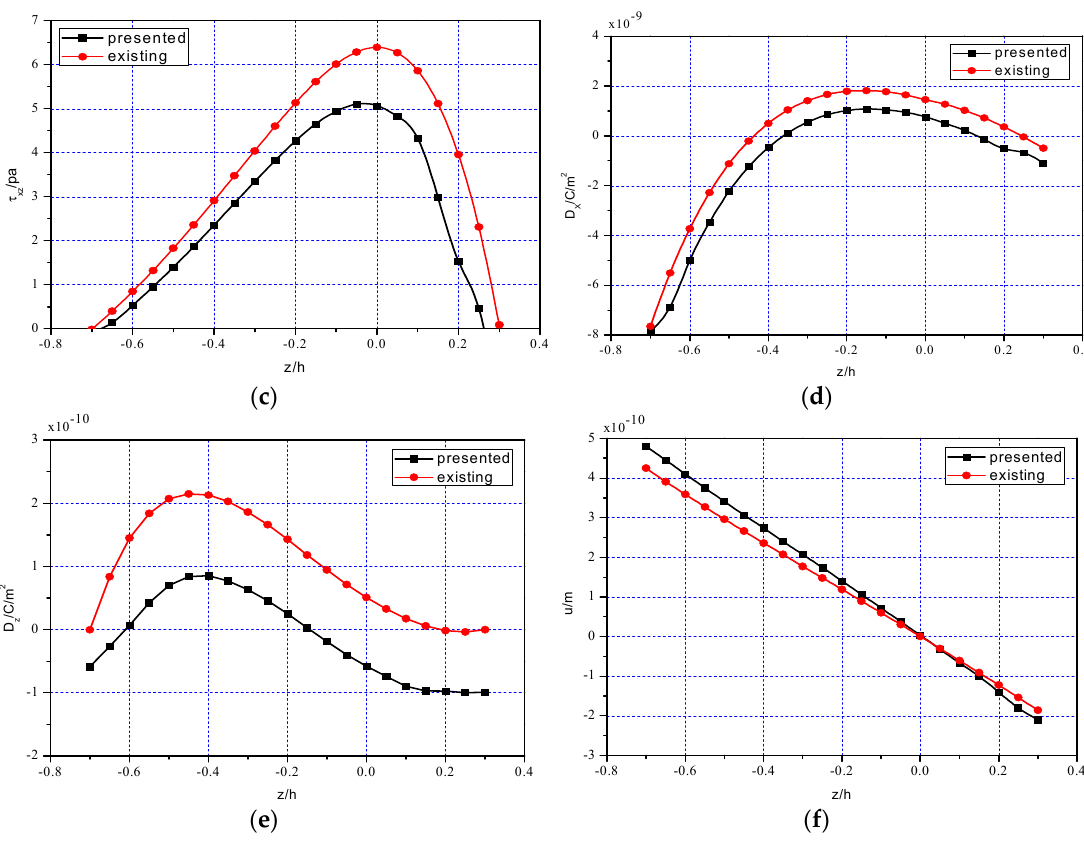
Figure 10. Comparisons of two-dimensional simulation presented in this study and existing solution from He et al. [27] at x = 0.75 l : ( a ) Stress σ x ; ( b ) Stress σ z ; ( c ) Stress τ xz ; ( d ) Electrical displacement D x ; ( e ) Electric displacement D z ; ( f ) Mechanical displacement u .